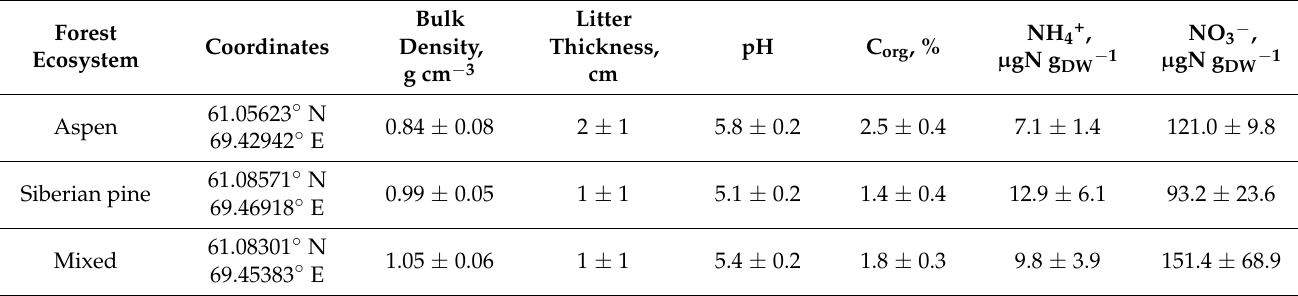
Table 1. Soil properties of sampling plots (for the A horizon, 3–5 cm from the surface, values represent means ± SEM for 2 spatial replicates across all